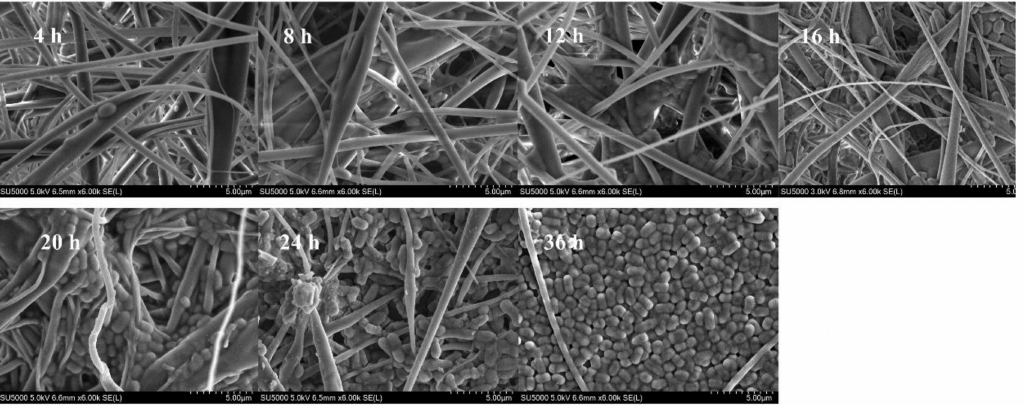
Figure 5. SEM images of biofilms formed on EC nanofiber mats by L. plantarum GIM1.648 at different culture times.